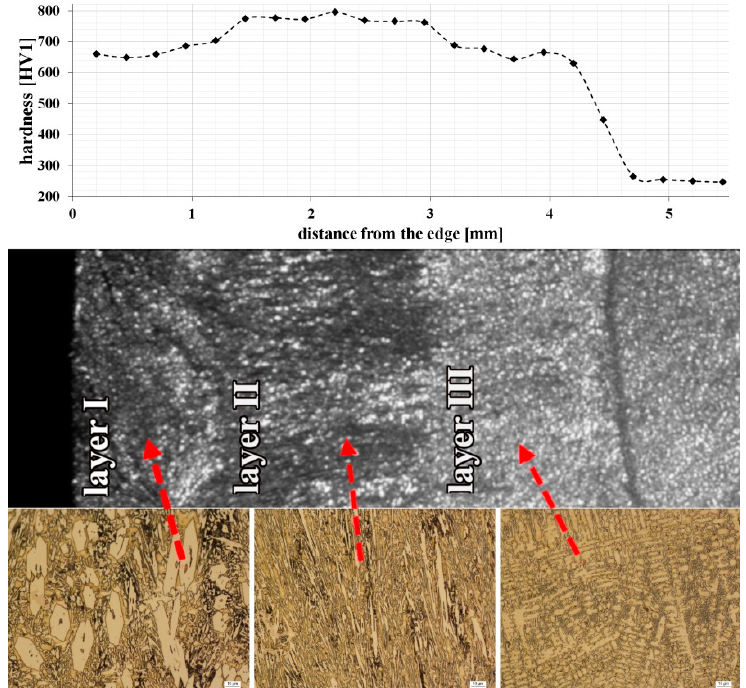
Figure 4. Hardness distribution of the tested claddings produced by welding with distinguished zones characterized by a different microstructure.